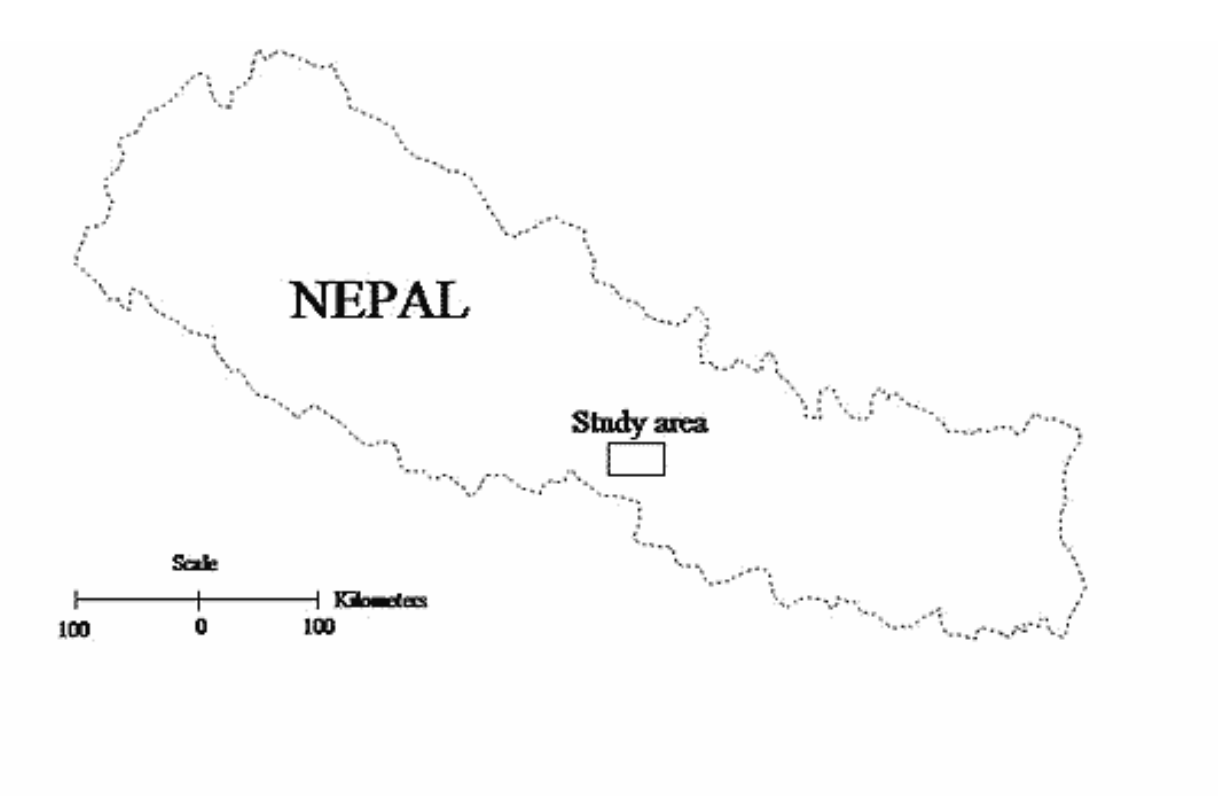
Fig. 1 . Location of study area in East Chitwan,